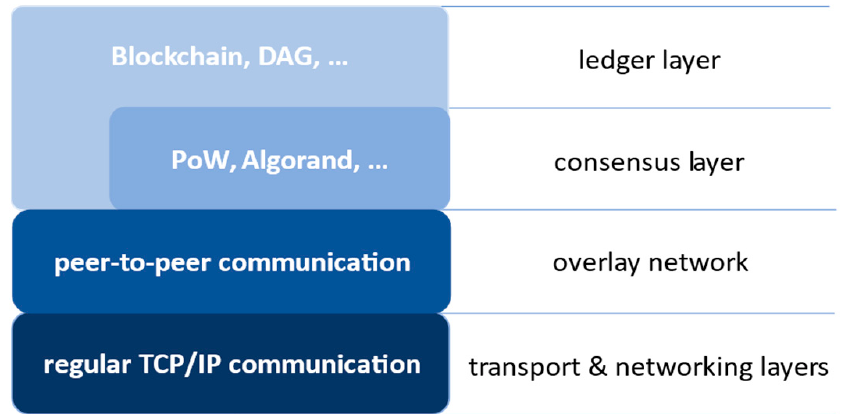
Figure 2. The core networking with overlay and consensus protocols for ledger technologies.